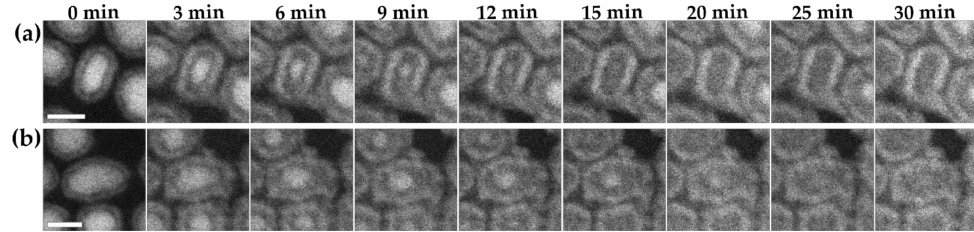
Figure 8. ( a , b ) In situ visualization and analysis of dynamic oxidation of two different rods of Fe 2 C in HAADF-ESTEM at 200 ◦ C with 2 Pa oxygen. The figure shows two elongated nanoparticles ( a , b ) over a period of 30 min. The images have a 10 nm scale